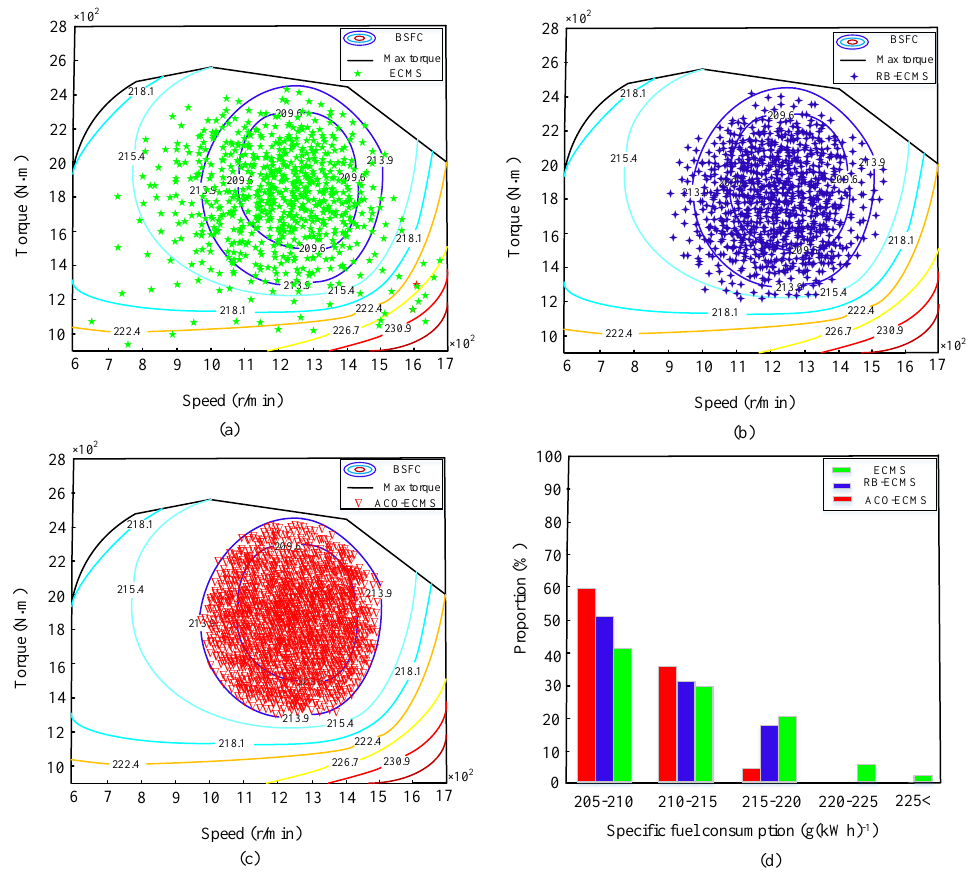
Figure 14. Comparison of fuel consumption rate of diesel engine with three control strategies ( a ) ECMS. ( b ) RB-ECMS. ( c ) ACO-ECMS. ( d ) Distribution statistics of engine operating points under the T condition.